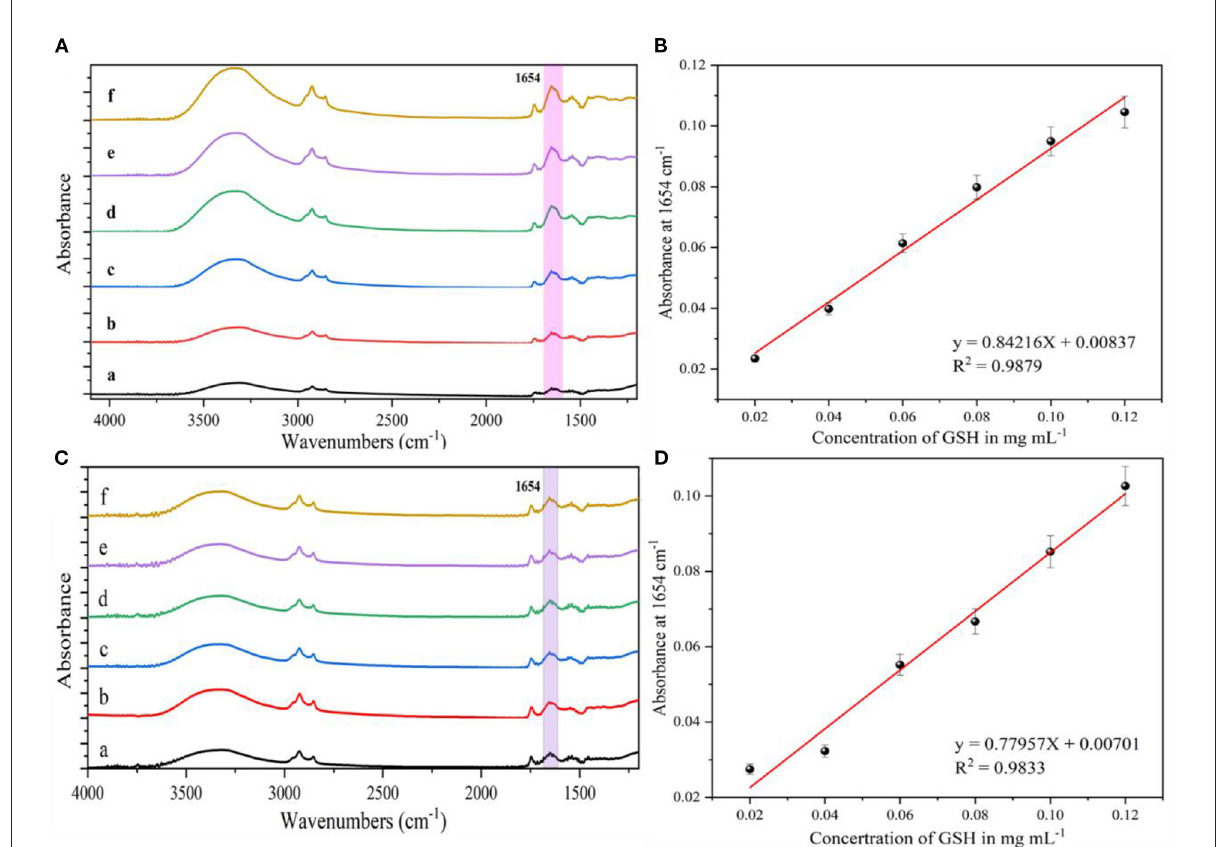
FIGURE7 (A) SEIRA spectra of different concentrations of glutathione in milk, (a) 0.02 mg/mL; (b) 0.04 mg/mL; (c) 0.06 mg/mL; (d) 0.08 mg/mL; (e) 0.1 mg/mL; (f) 0.12 mg/mL. (B) IR absorption peak intensity at 1,654 cm − 1 in relation to glutathione in milk relationship. (C) SEIRA spectra of